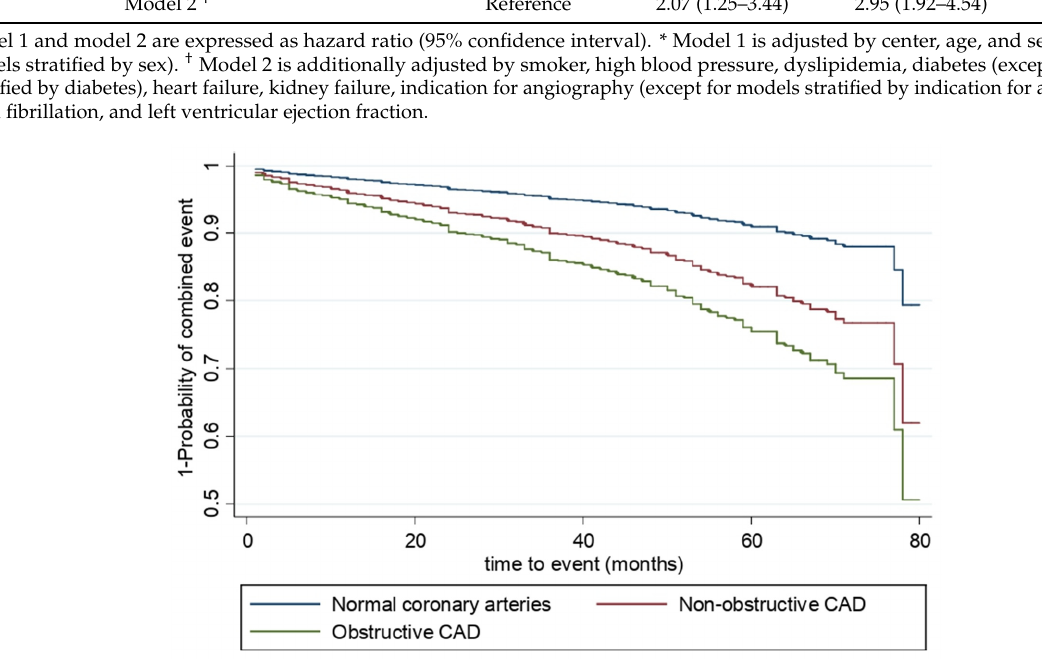
Figure 1. Adjusted Kaplan-Meier curves for combined event (acute myocardial infarction, stroke, hospitalization for heart failure or cardiovascular death) according to the degree of CAD using Cox proportional hazards regression. The models are adjusted by smoker, high blood pressure, dyslipidemia, diabetes, heart failure, kidney failure, indication for angiography, atrial fibrillation, and left ventricular ejection fraction. CAD: coronary artery disease.